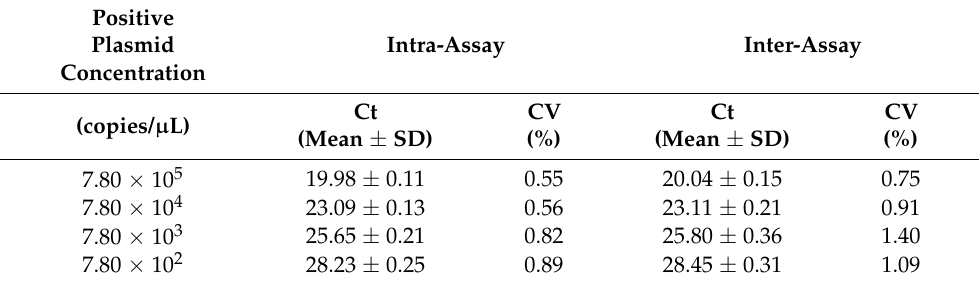
Table 2. Repeatability test of RT-qPCR.